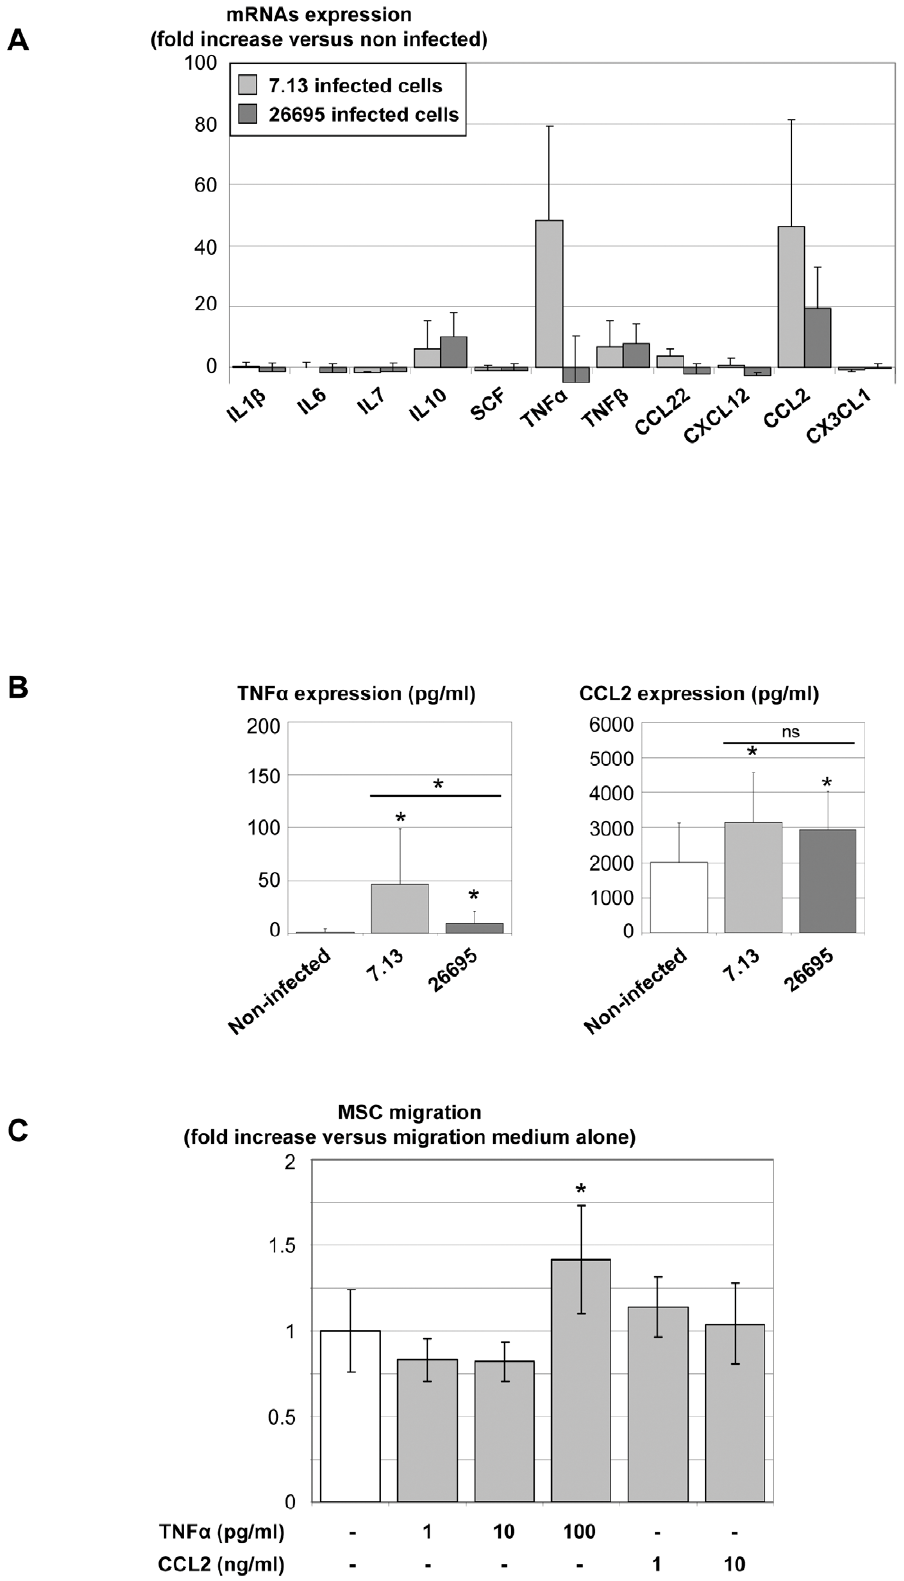
Figure 3. Epithelial cytokine expression and MSC migration. A/ After an 18 h coculture of epithelial cells with H. pylori 26695 or 7.13 strains in migration medium, mRNAs were extracted and mRNA expression of cytokines was measured by qRT-PCR. Results were expressed as fold increases compared to non-infected cells. Results correspond to the mean of 3 independent experiments 6 SD. B/ Supernatants from non-infected (white